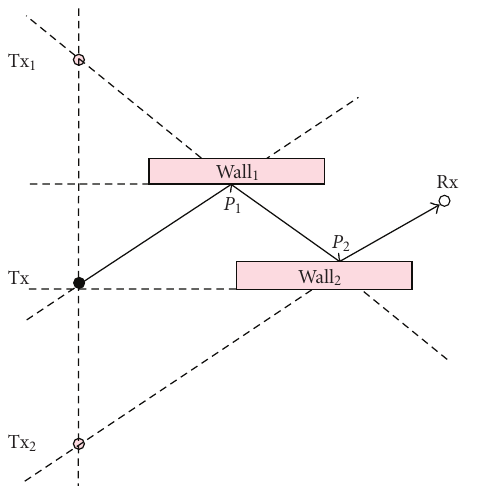
Figure 4: Source image method.